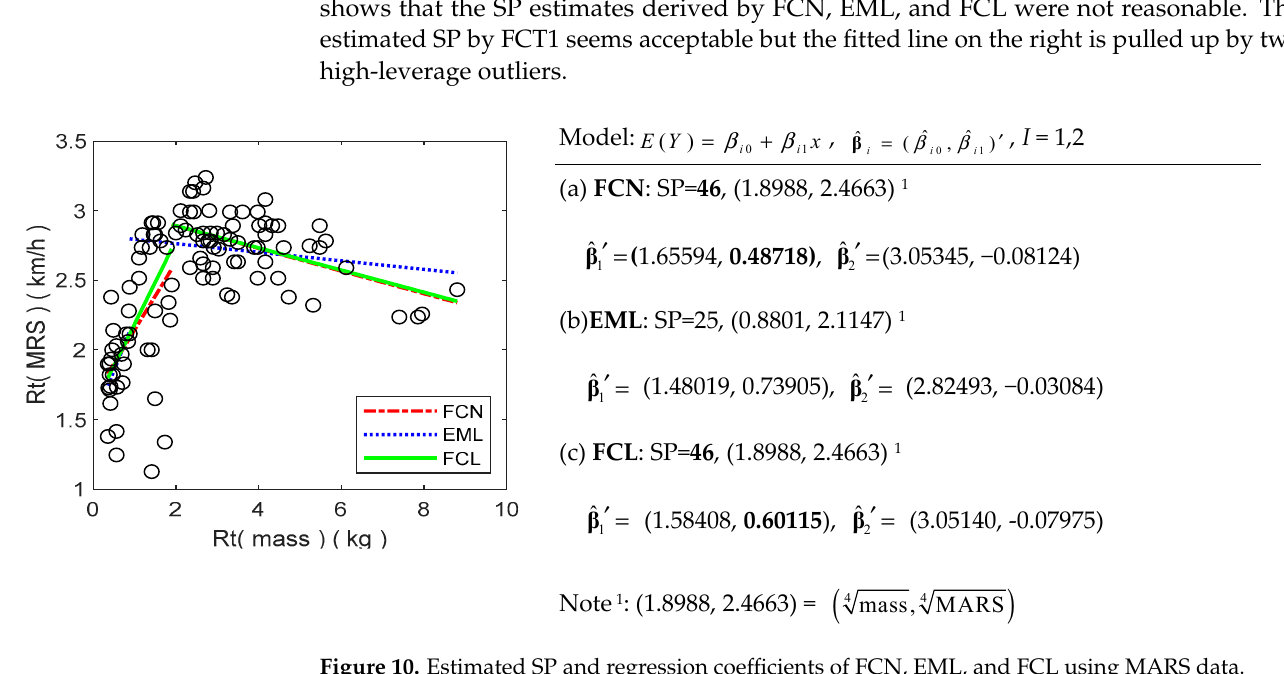
Figure 10. Estimated SP and regression coefficients of FCN, EML, and FCL using MARS data. Example 2. We applied the proposed method to a dataset from